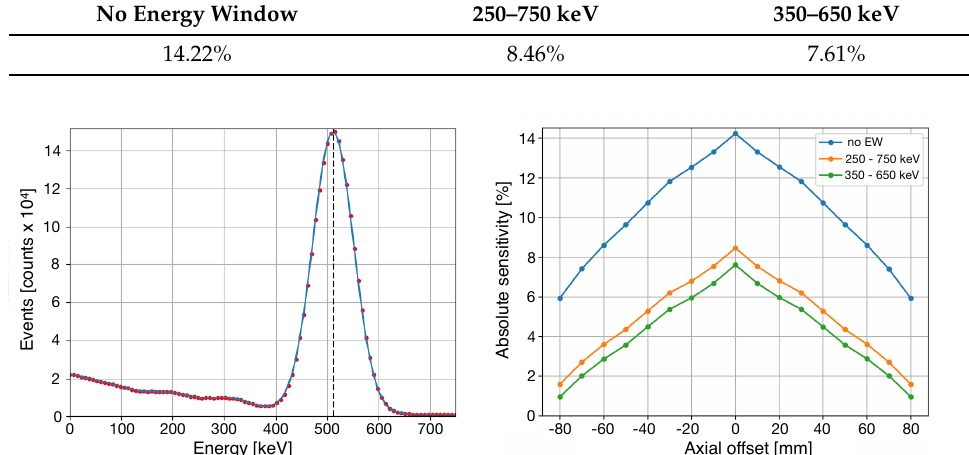
Figure 4. ( Left ) Coincidence energy spectrum. ( Right ) Sensitivity values across the axial direction for different energy